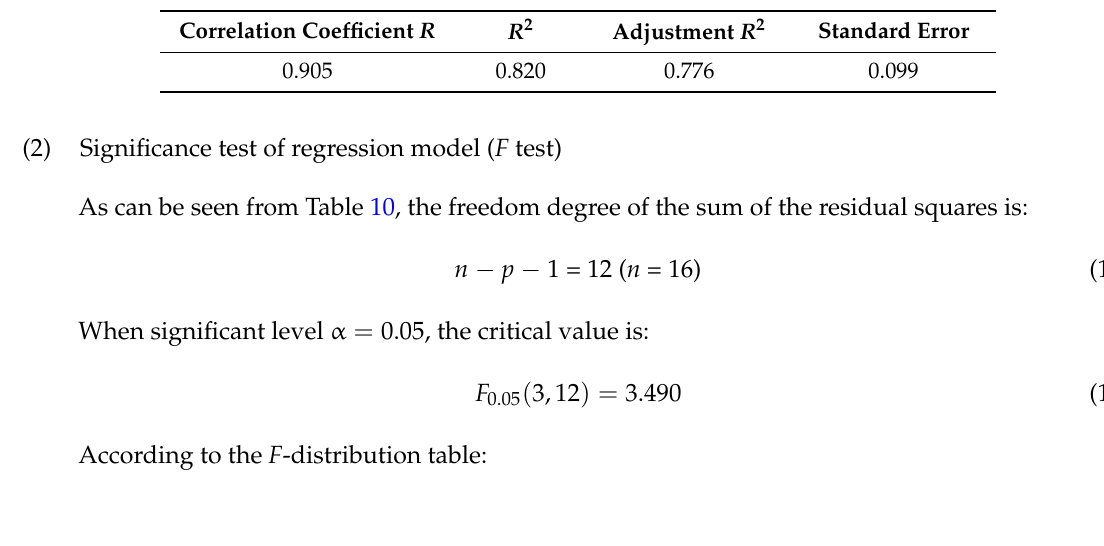
Table 9. Goodness of fit for regression model of milling